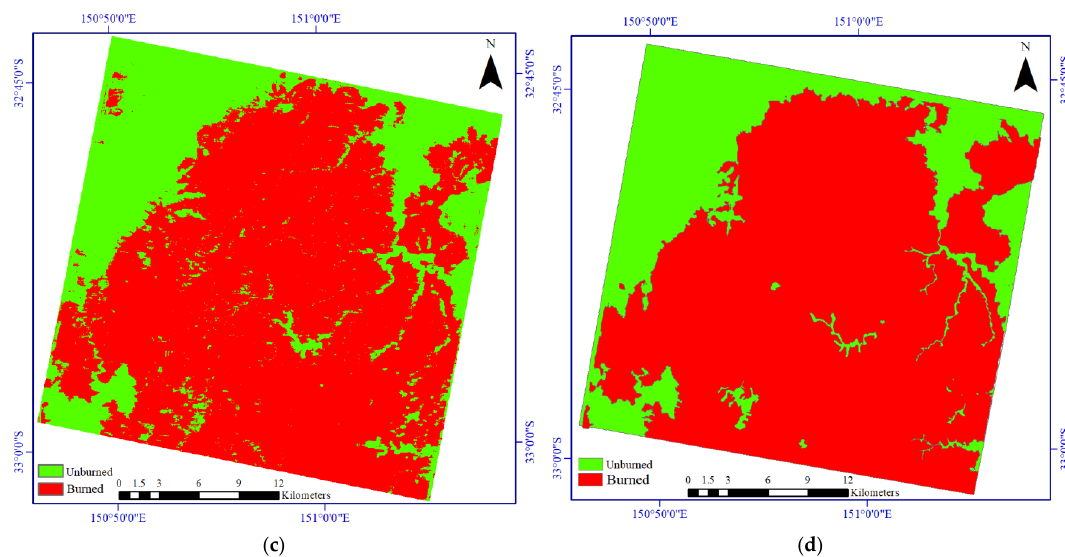
Figure 7. Visual comparisons of the results for the burned area mapping based on the post/pre-event Sentinel-2 imagery for the first study area. ( a ) Deep Siamese network. ( b ) Using the CNN method proposed in [42]. ( c ) Using the method proposed in the present study. ( d ) Ground truth map.